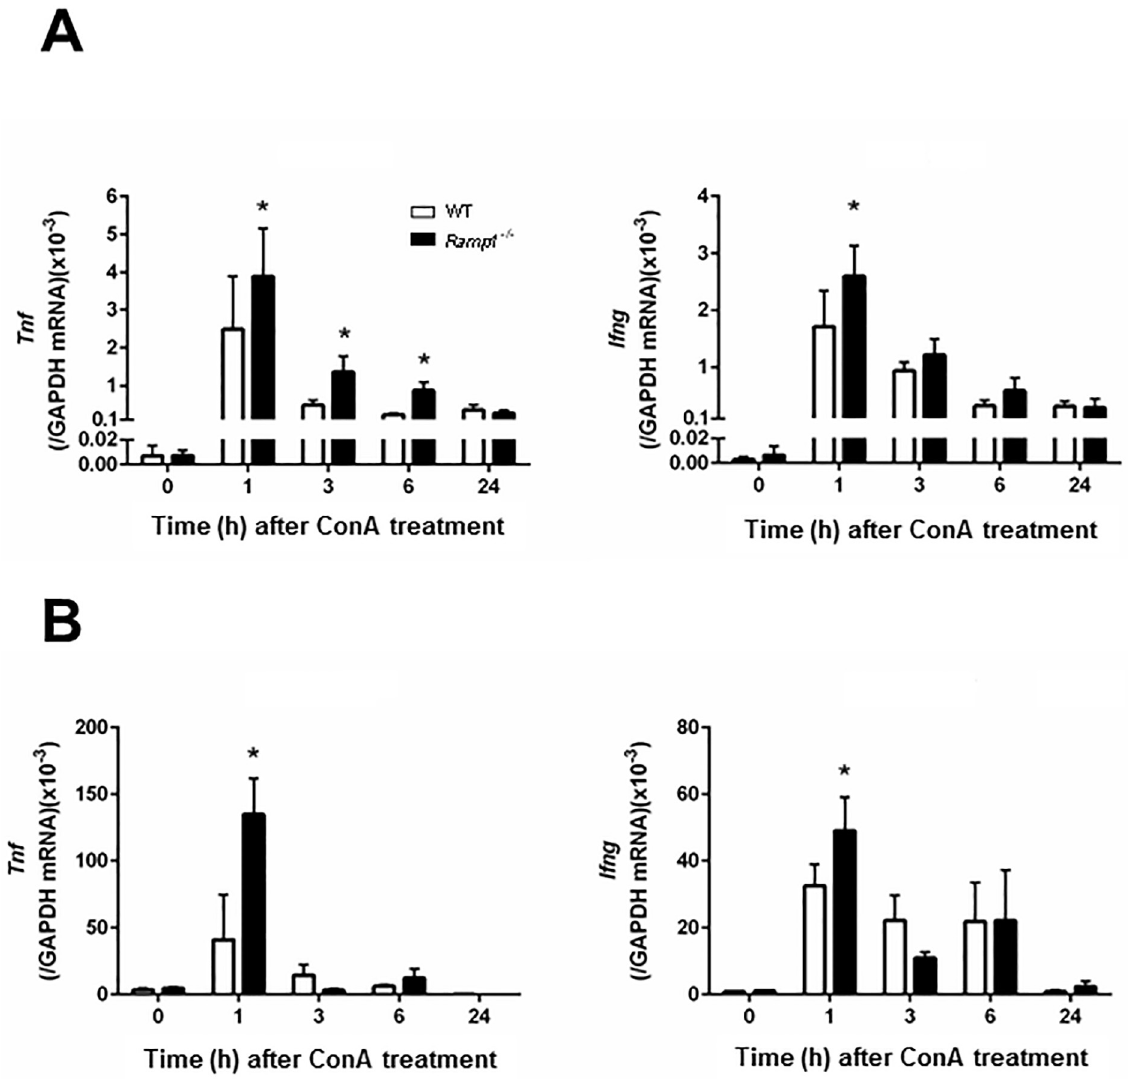
Fig 2. Increased expression of pro-inflammatory cytokines in Ramp1 -/- mice with ConA hepatitis. Time course of changes in mRNA levels of Tnf and Ifng in the liver (A) and spleen (B) of WT and Ramp1 -/- mice after ConA treatment. Data are expressed as the mean ± SD from six mice per group. � p < 0.05 vs . WT